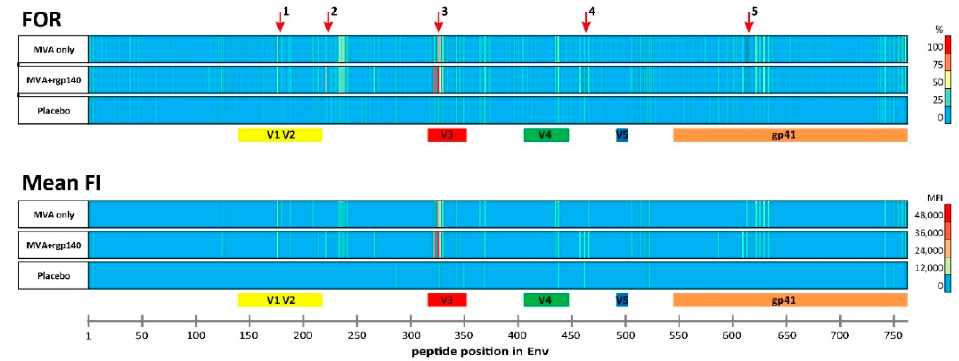
Figure 1. Heat map of frequency of responders (FOR) and mean fluorescence intensity (FI) plotted against individual antigenic regions along the entire HIV-1 Env as included in the peptide microarray. Heat maps of antigenic regions targeted by Env-specific IgG responses are shown for both vaccination groups and the placebo group four weeks after the last vaccination. Each row represents one of the boosting vaccination arms (HIV-MVA only n = 28; HIV-MVA + CN54rgp140 / GLA-AF n = 32) and the placebo arm ( n = 11). FI values corresponding to each peptide were mapped to the 10 full-length Env sequences included in the peptide array (HIV primary isolates subtypes A, B, C, CRF01_AE and CRF02_AG, and HIV vaccines HIV-MVA (CRF01_AE) and CN54rgp140 (subtype C)). Responses above 2500 FI after baseline subtraction were considered positive and the maximum FI was selected per position (Supplemental Figure S1). The frequency of positive responses ( > 2500 FI) was calculated per peptide positions and is given as frequency of responders (FOR) in the upper graph. The mean FI depicted in the lower graph was calculated from the maximum FI per peptide position of each vaccinee per group and is shown for positive responses against peptide positions with a FOR > 25%. Immunodominant regions (IDRs) 1–5 are indicated by red arrows and are listed in Table 2. Table 2. Summary of immunodominant regions detected in vaccinees. FOR (%) Mean FI Env Representative HXB2 Peptide IDR MVA MVA Region Sequence Position Position MVA + rgp140 Placebo MVA + rgp140 Placebo Only Only 1_V2 176 164 V2 ELRDKKQKVHALFYK 0 2_C2 221 200 C2 AITQACPKVTFDPIP 0